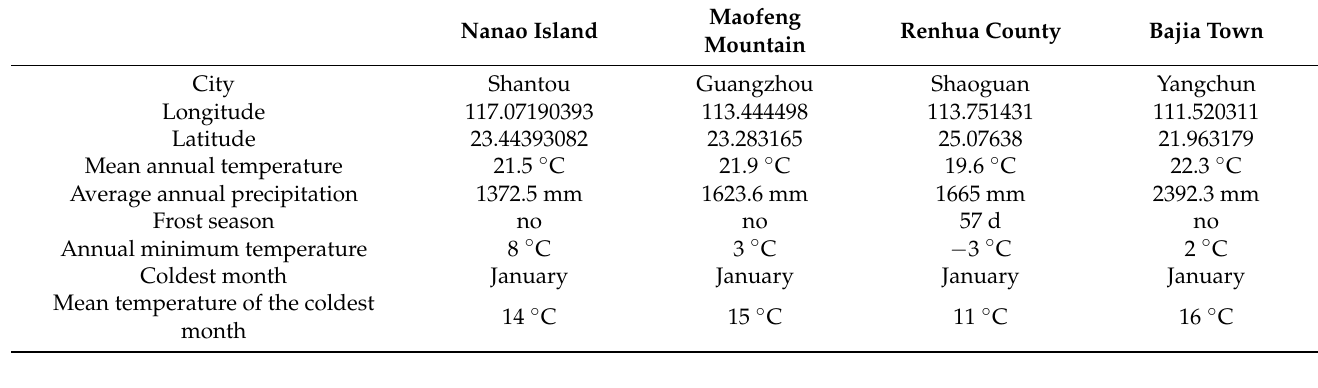
Table 4. Comparison of environmental conditions between the reintroduced area and Nanao Island.